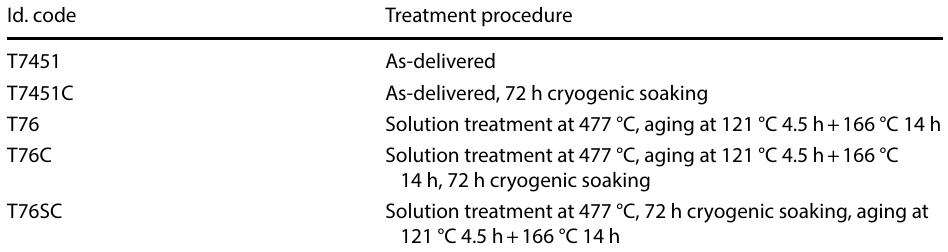
Table 2 Details of the laboratory heat-treating procedures